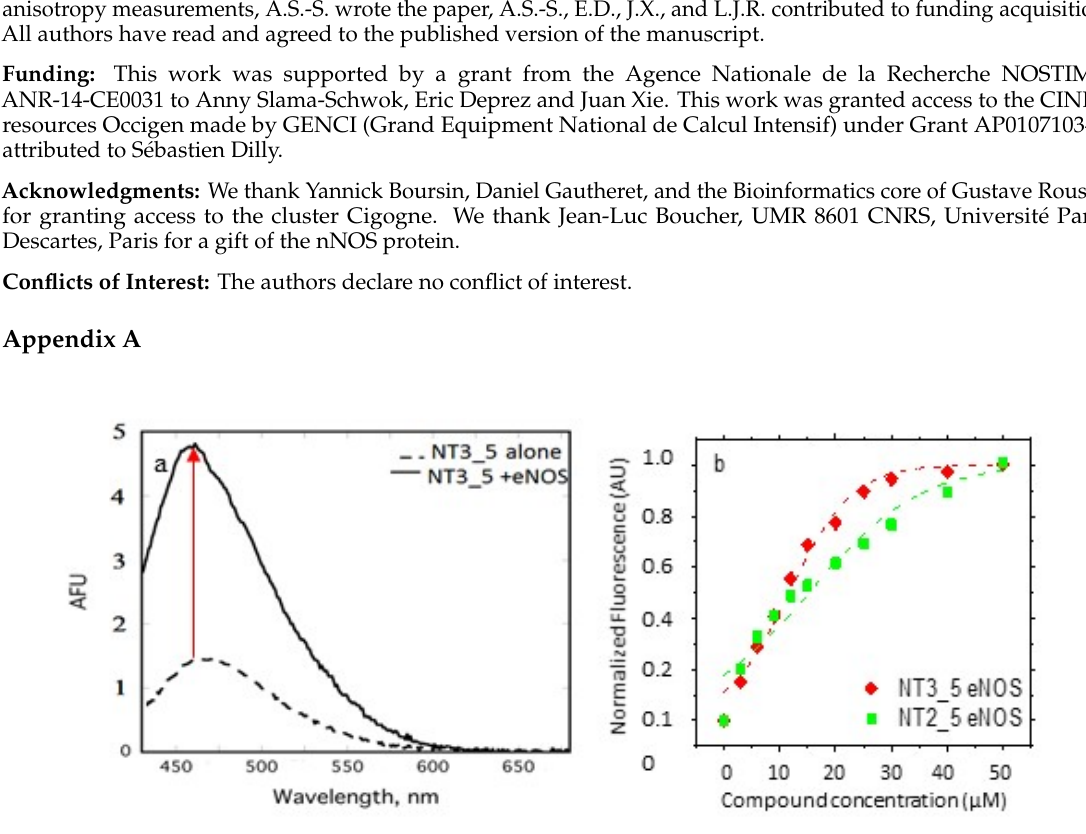
Figure A1. ( a ) Spectral changes of NT3_5 upon binding to eNOS. Fluorescence emission spectra were recorded from 430–680 nm (excitation = 420 nm; slit width = 5 nm) for NT3_5 (10 µ M) alone and for eNOS (5 µ M) + NT3_5 (10 µ M). Spectrum of intrinsic protein fluorescence (due to flavins) was subtracted from protein + NT spectrum. Fluorescence maxima were found at 470 nm and 450 nm for NT3_5 alone and eNOS + NT3_5, respectively, demonstrating an increase in fluorescence intensity and a blue shift upon binding to eNOS. ( b ) Titration of eNOS with NT2-5, NT3_5. Fluorescence emission spectra were recorded from 430–680 nm (excitation = 420 nm; slit width = 5 nm). Spectra of intrinsic protein fluorescence and unbound NT were subtracted from protein / NT spectra, and fluorescence at 460 nm was plotted. Representative data (out of four experiments in each NT) have been fitted by a single dose–response (NT2_5, NT3_5) (Table 1).